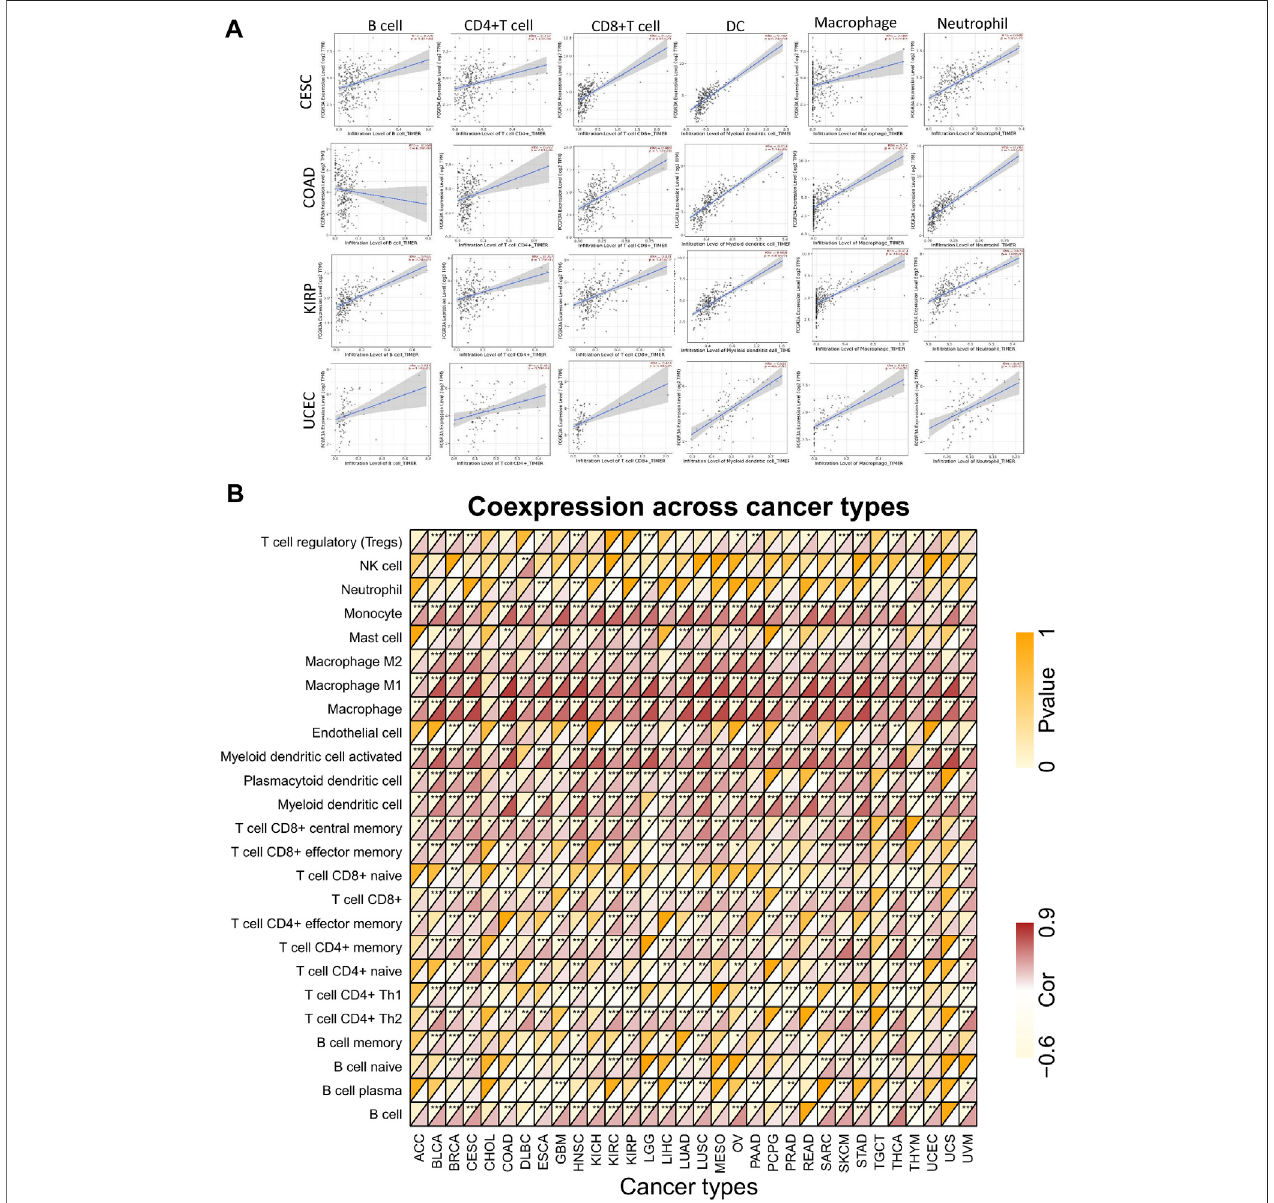
FIGURE 4 | Correlation analysis ofFCGR3A expression with immune cells in fi ltration. (A) The scatter plot showed acorrelation between FCGR3A and the levels of in fi ltration of six major immune cells in CESC, COAD, KIRP, and UCEC; (B) Heat map showed the relationship between FCGR3A expression and 25 immune cell markers. CESC, cervical squamous cell carcinoma and endocervical adenocarcinoma; COAD, colon adenocarcinoma; KIRP, kidney renal papillary cell carcinoma; UCEC, uterine corpus endometrial carcinoma. * p < 0.05; ** p < 0.01; *** p < 0.001.